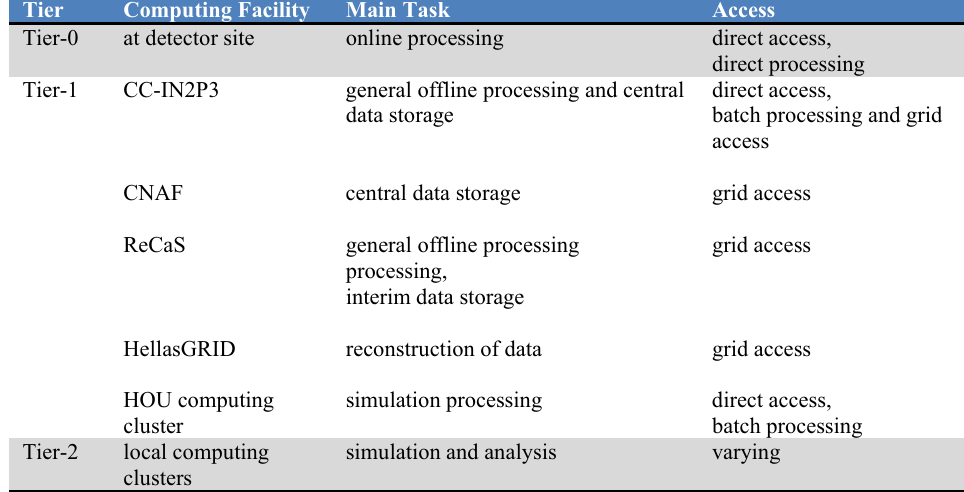
Table 1. KM3NeT Computing